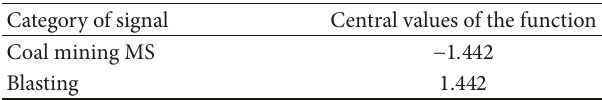
Table 2: Structure matrix. Table 3: Central values of the final discriminant function in the coal mining MS signals and blasting signals.